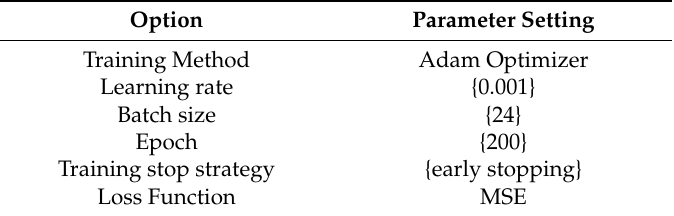
Table 2. The parameter setting detail of DWT-CNN-LSTM model.